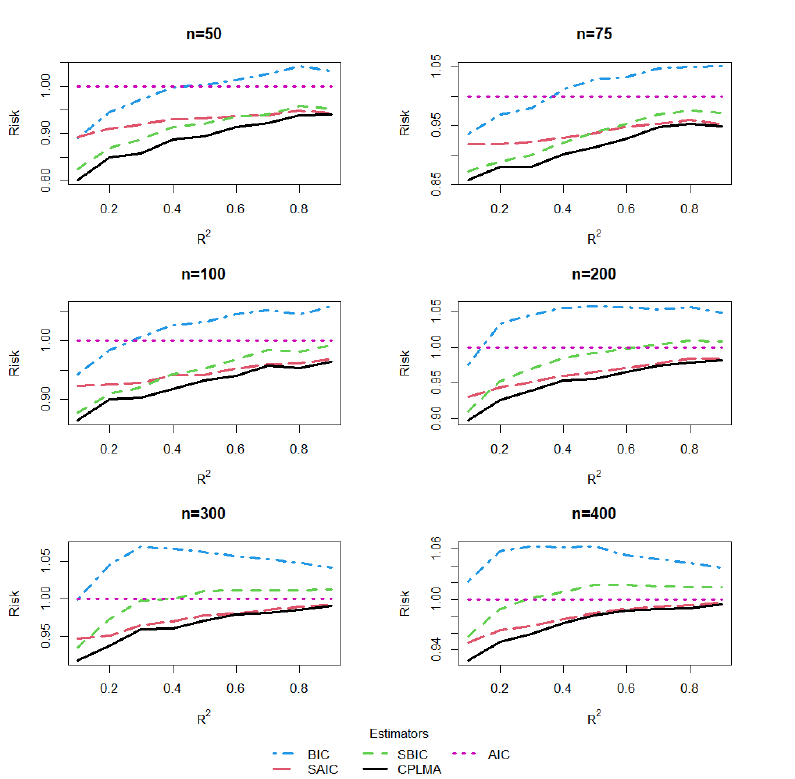
Figure 5. Risk comparisons for Design 1 when α = 0.5 and the censoring rate is about 40%.